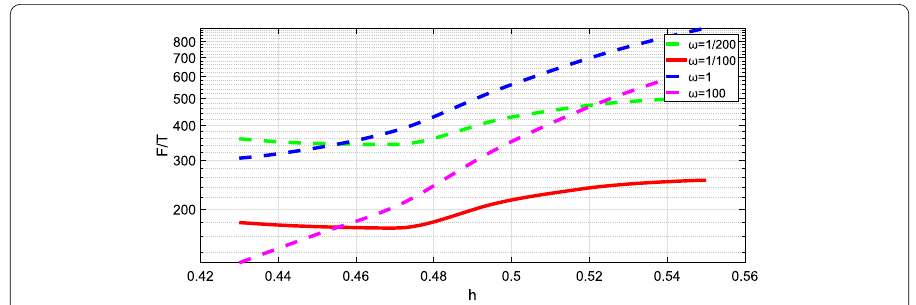
Figure 12 The change in the cost per unit time F / T on the economic threshold h for ω =